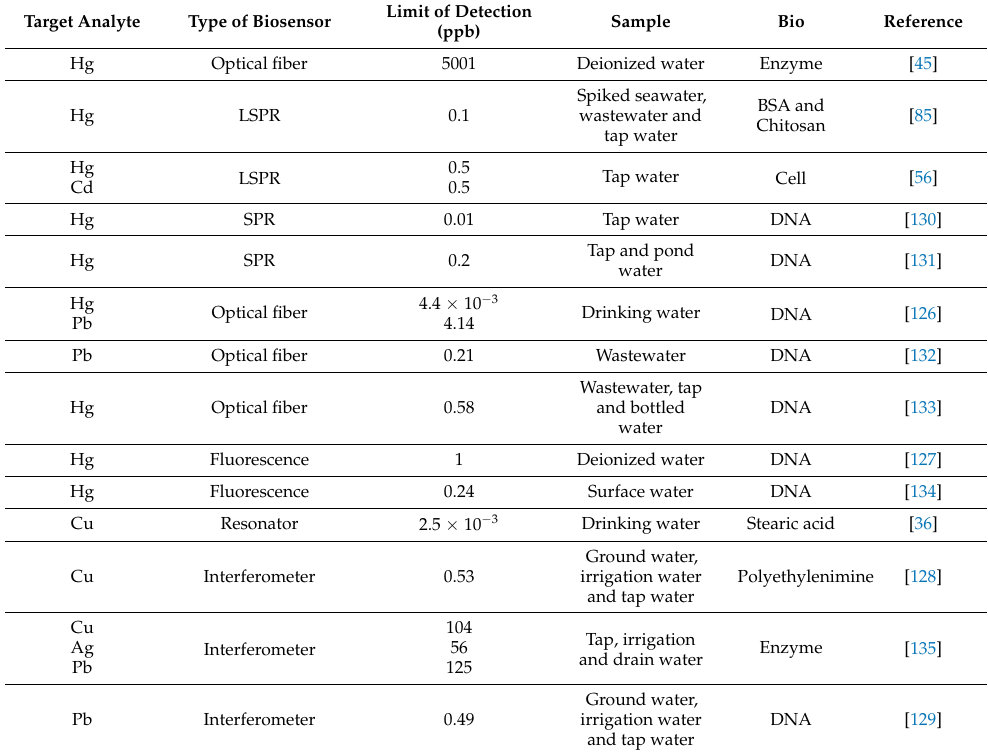
Table 6. Published work on detection of heavy metals in water. Target Analyte Type of Biosensor